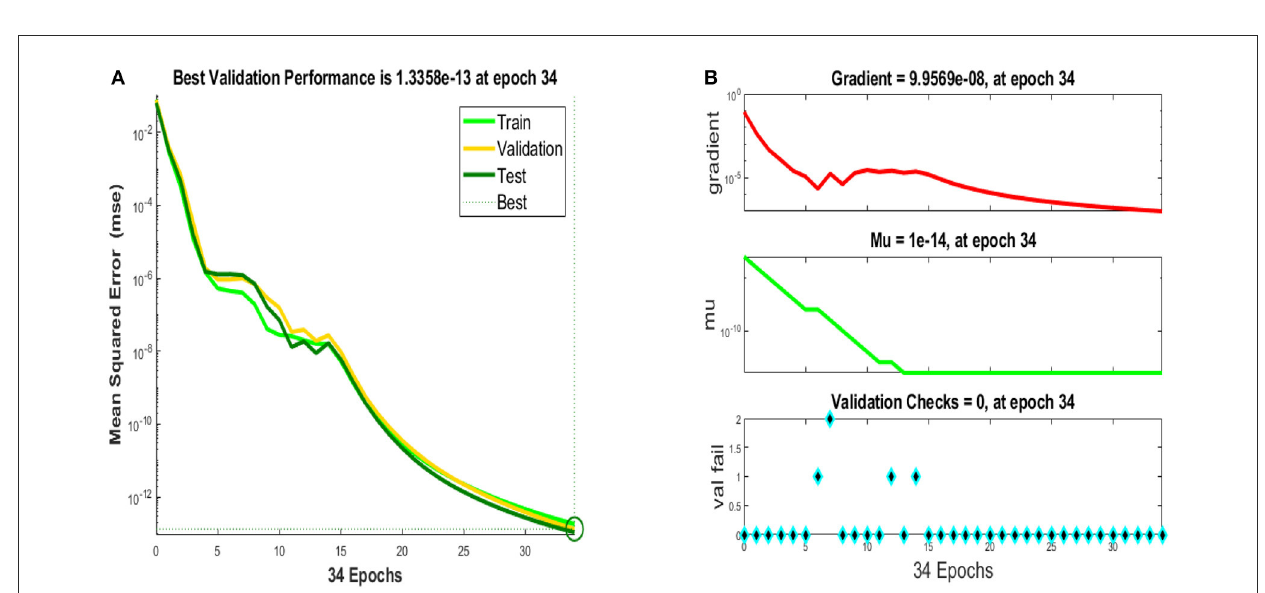
FIGURE8 MSE and STs performances for the HBV system. (A) MSE: Case 3. (B) EHs: Case